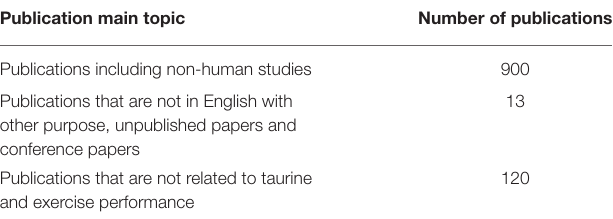
TABLE 2 | Number of publications in exclusion criteria based on its main topic.